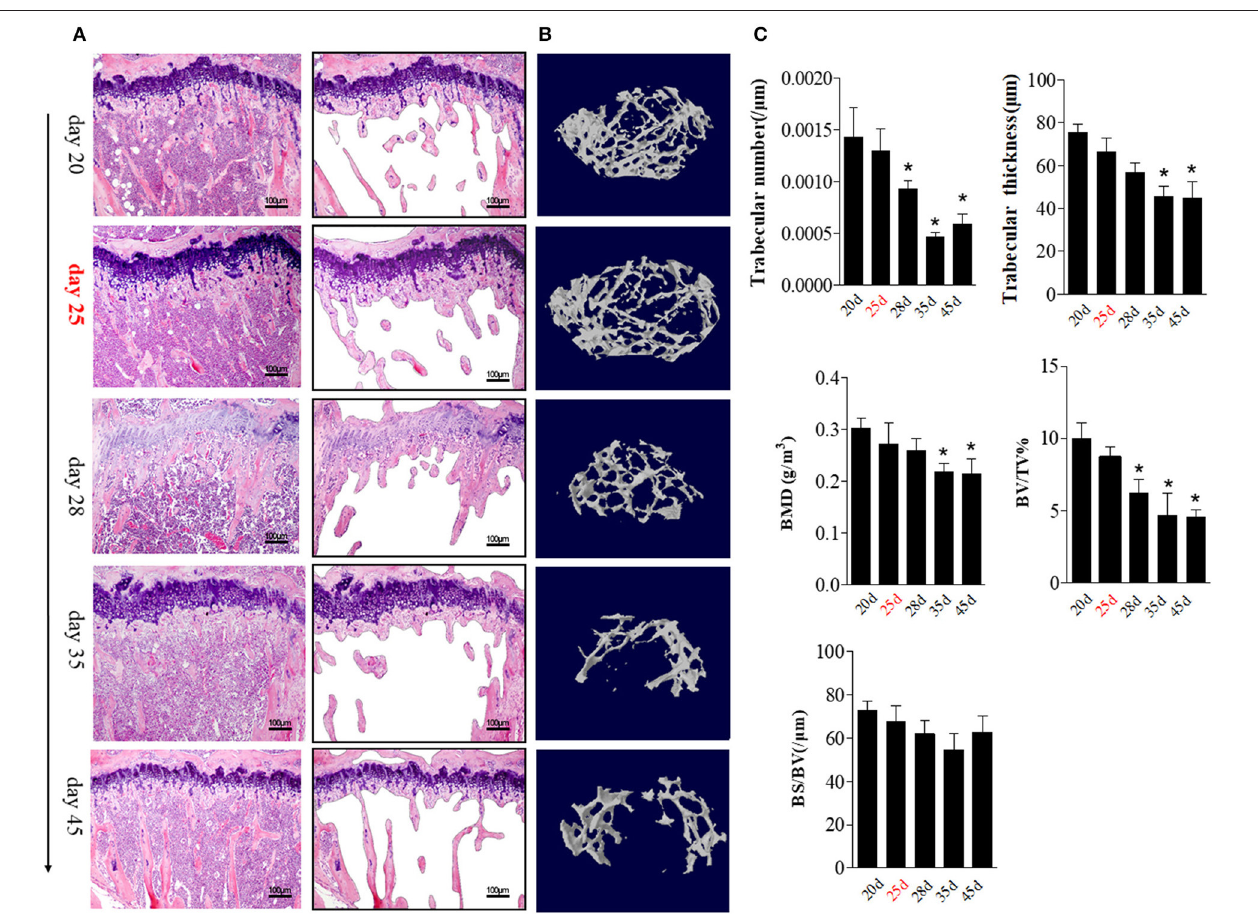
FIGURE 5 | BME links to the changes of trabecular bone during the development of CIA. (A) HE staining showed the changes in trabecular bone at the indicated time ( n = 5). The trabecular bone outline shaped by photoshop software was showed on the right. (B) Representative longitudinal 3D micro-CT images showing changes in trabecular bone microarchitecture regions from the CIA mice at the indicated time point. (C) Structural parameters in these CIA mice. Values are means ± SD (* p < 0.05, compared with day 20). The first time of BME appearance during the CIA process was marked with red. All experiments were repeated three